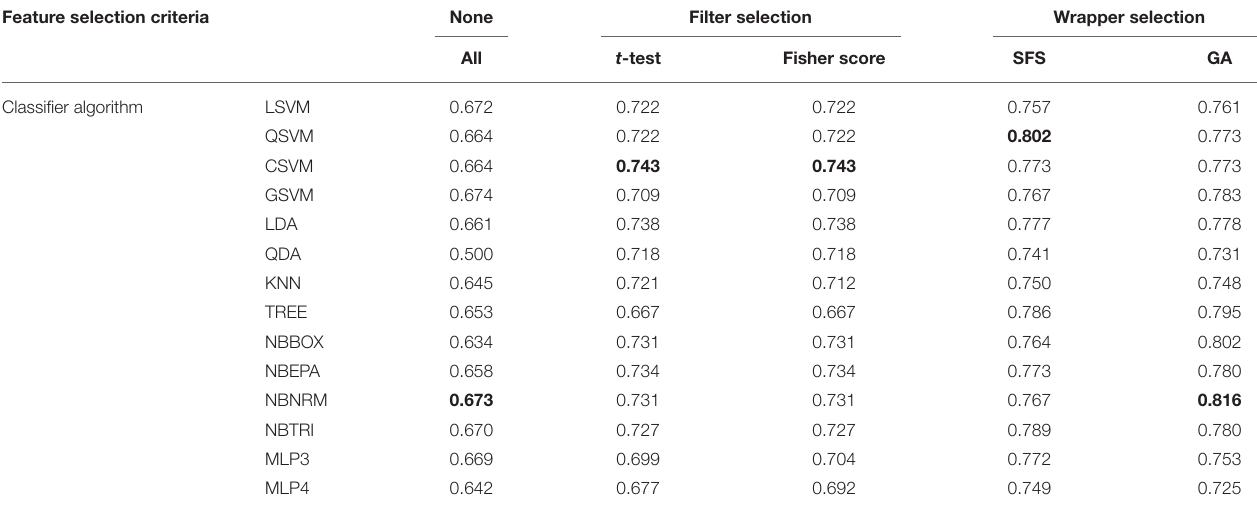
TABLE 2 | Balanced accuracy of models per feature selection method and classifier algorithm. Feature selection criteria